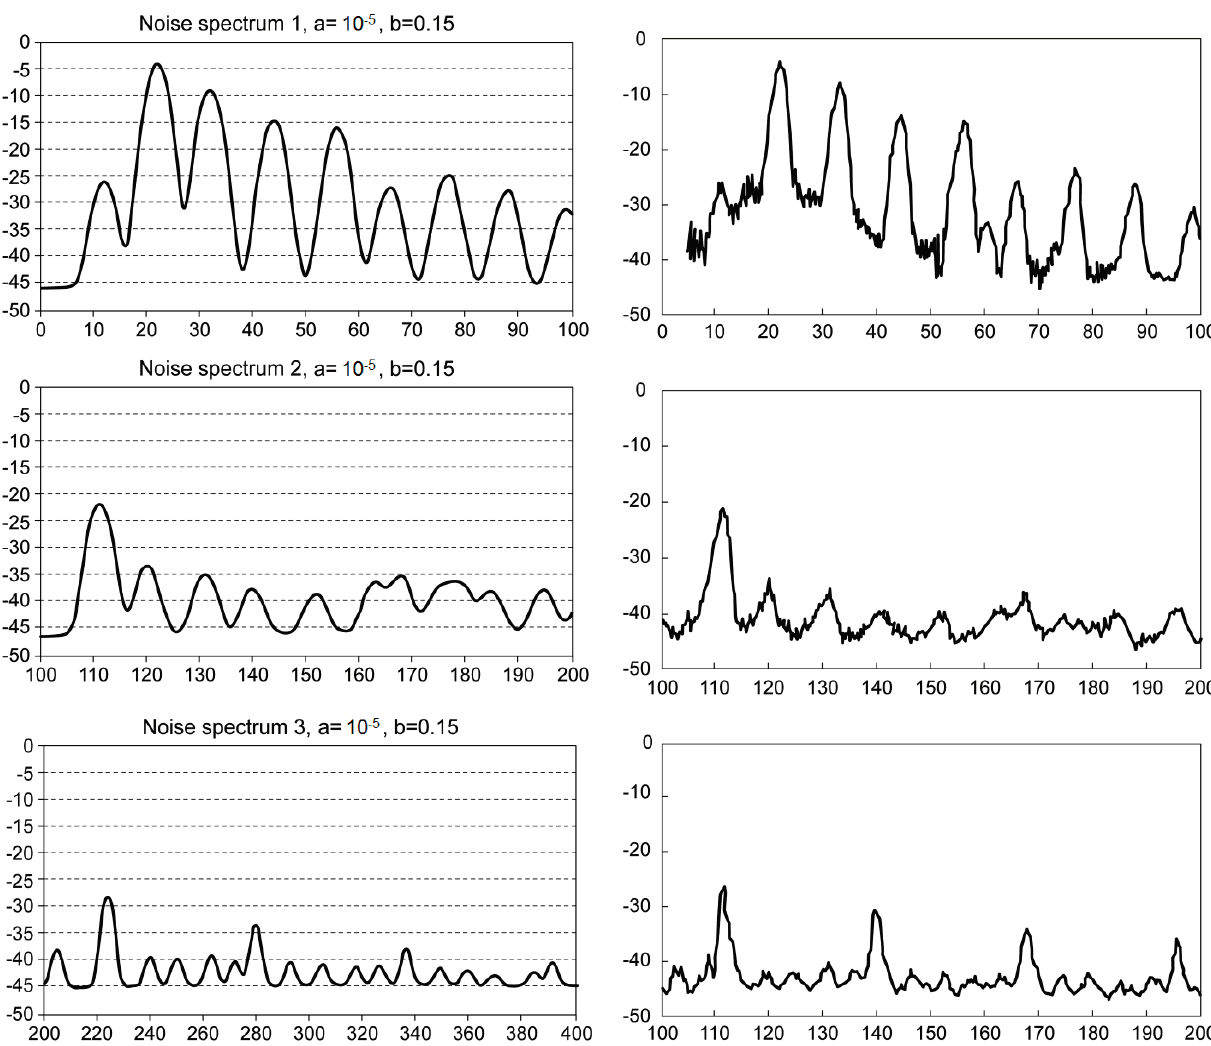
Figure 9. Discrete and broadband helicopter rotor noise. The rotor noise due to blade-vortex interaction (BVI) consists of sound pulses (Figure 1) emitted by a vortex when it is convected past a blade. The rotating blades hit the wake of the preceding blades leading to a periodic train of pulses. The resulting noise spectrum consists [54] mainly of the fundamental blade passing frequency (BPF) and its harmonics, and is discrete apart from background noise. The BVI noise pulses propagate through the non-uniform and turbulent flow around the rotor leading to spectral broadening (Figure 9) that: (i) broadens the discrete tones; (ii) attenuates more the higher frequencies; (iii) increases the continuous spectrum above the background noise; (iv) eventually absorbs the highest frequency tones into the enhanced background continuous spectrum. This process of spectral and directional broadening also applies to aircraft noise propagating through atmospheric turbulence to the